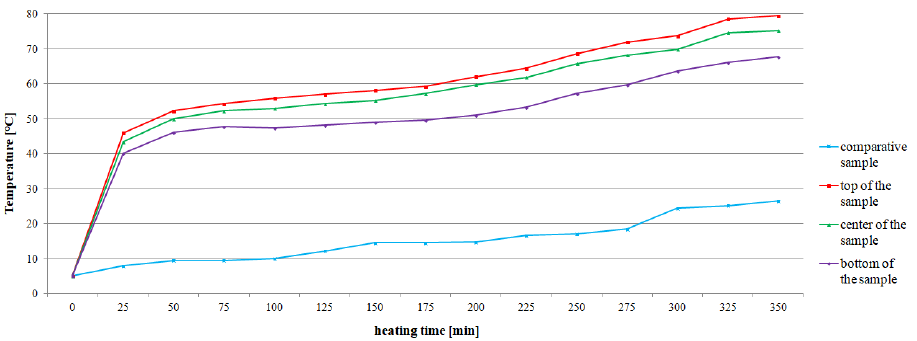
Figure 8. Change of the average temperature of CC-1 concrete as a function of heating time and test site on the sample.